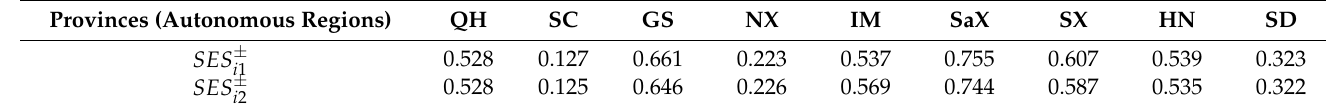
Table A5. The SES ± for COD and the SES ± for NH 3 -N in nine provinces (autonomous regions). i 1 i 2